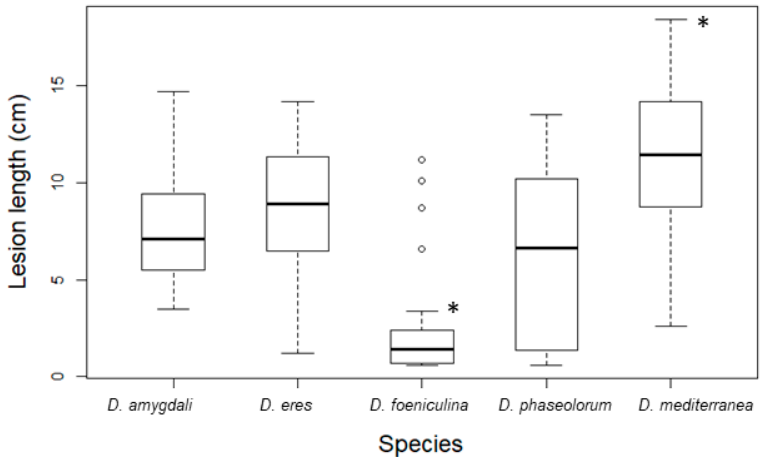
Figure 6. Box plot of lesion length (cm) caused by Diaporthe spp. on almond detached twigs inoculated (n = 12 per isolate) with isolates of D. amygdali (seven isolates), D. eres (one isolate), D. foeniculina (two isolates), D. phaseolorum (one isolate) and D. mediterranea (three isolates). Black lines in the boxes show medians. Asterisks (*) indicate that values are significantly different than D. amygdali according to the Wilcoxon rank sum test ( p < 0.01).